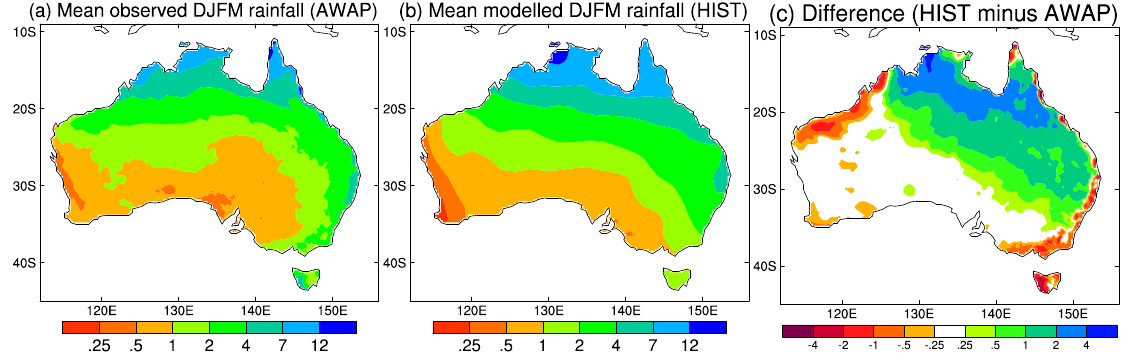
Fig. 5. DJFM rainfall, averaged over 1980 to 2005 (in mm per day): (a) observations from AWAP, (b) from the HIST ensemble mean, (c) HIST minus AWAP. The model output was interpolated to the finer (0.25 ◦ ) AWAP grid prior to